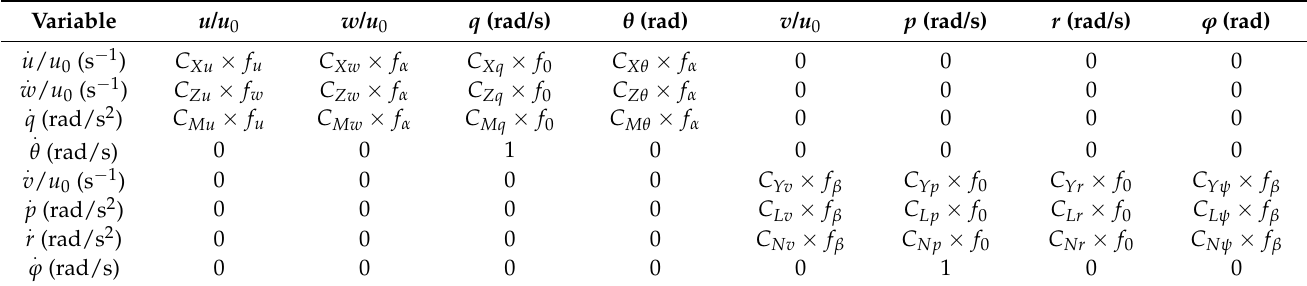
Table 2. Extrapolation factors for stability